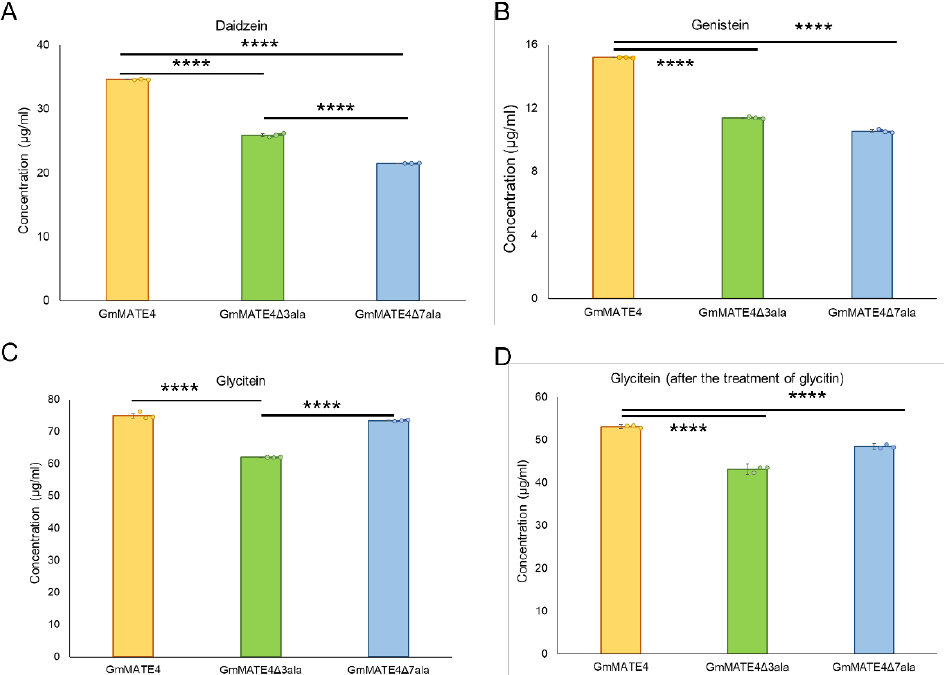
Figure 5. Uptake assays of isoflavones. The isoflavones detected in the yeast cells after the treat- ments of ( A ) daidzein, ( B ) genistein, ( C ) glycitein, and ( D ) glycitin. Error bar: standard error from three technical repeats. Student’s t test (two-tailed) was performed to compare the isoflavone uptake capacity between the constructs. **** indicates p < 0.0001. The experiments were performed twice with similar results.